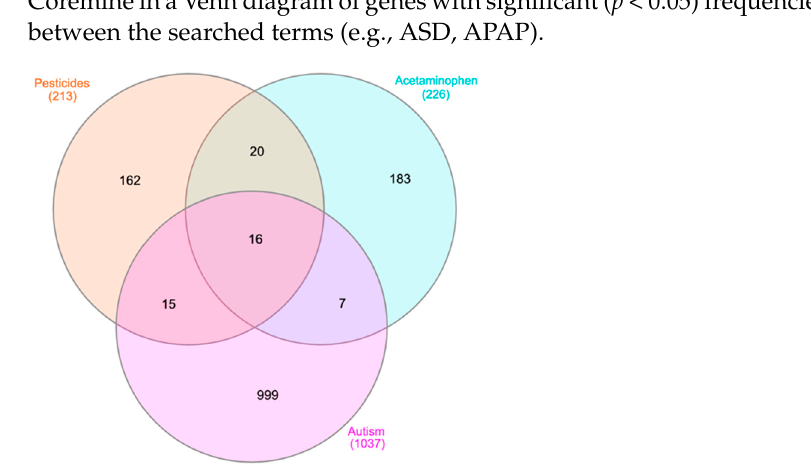
Figure 3. Venn diagram for genes retrieved from Coremine Medical associated with APAP, pesti- cides, and ASD. The 16 genes from the center of this Venn diagram are: CAT , CD4 , TNF , VEGFA , EGFR , INS , AGT , IL2 , FN1 , PTH , TP53 , ERBB2 , GCG , TSC1 , APP , and F2 . These 16 genes are used in IPA to perform canonical pathway analysis, the results of which are shown in Table 2. The 15 genes found to overlap between the pesticide and ASD nodes, as well as the seven genes overlapping between the APAP and ASD nodes, are listed in Appendix E as they may be synergizing in common pathways.